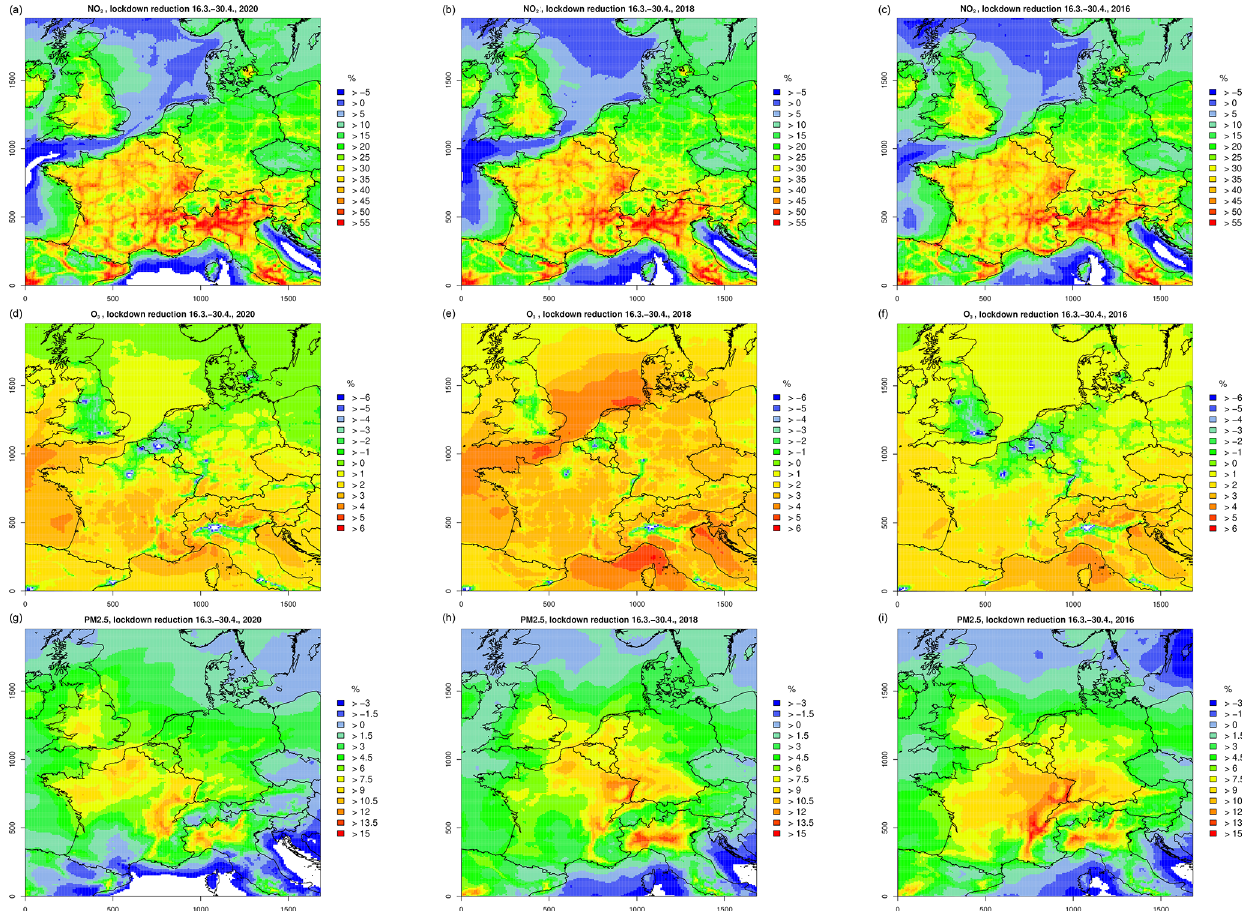
Figure 16. Relative concentration reductions due to lockdown measures (noCOV – COV run) in central Europe between 16 March and 30 April simulated with CMAQ for NO 2 (a–c) , O 3 (d–f) , and PM 2 . 5 (g–i) and three different meteorological input data sets. (a, d, g) 2020; (b, e, h) 2018; (c, f, i) 2016. Positive values denote concentration reductions caused by the lockdown emission changes. Be aware of the different scales for each